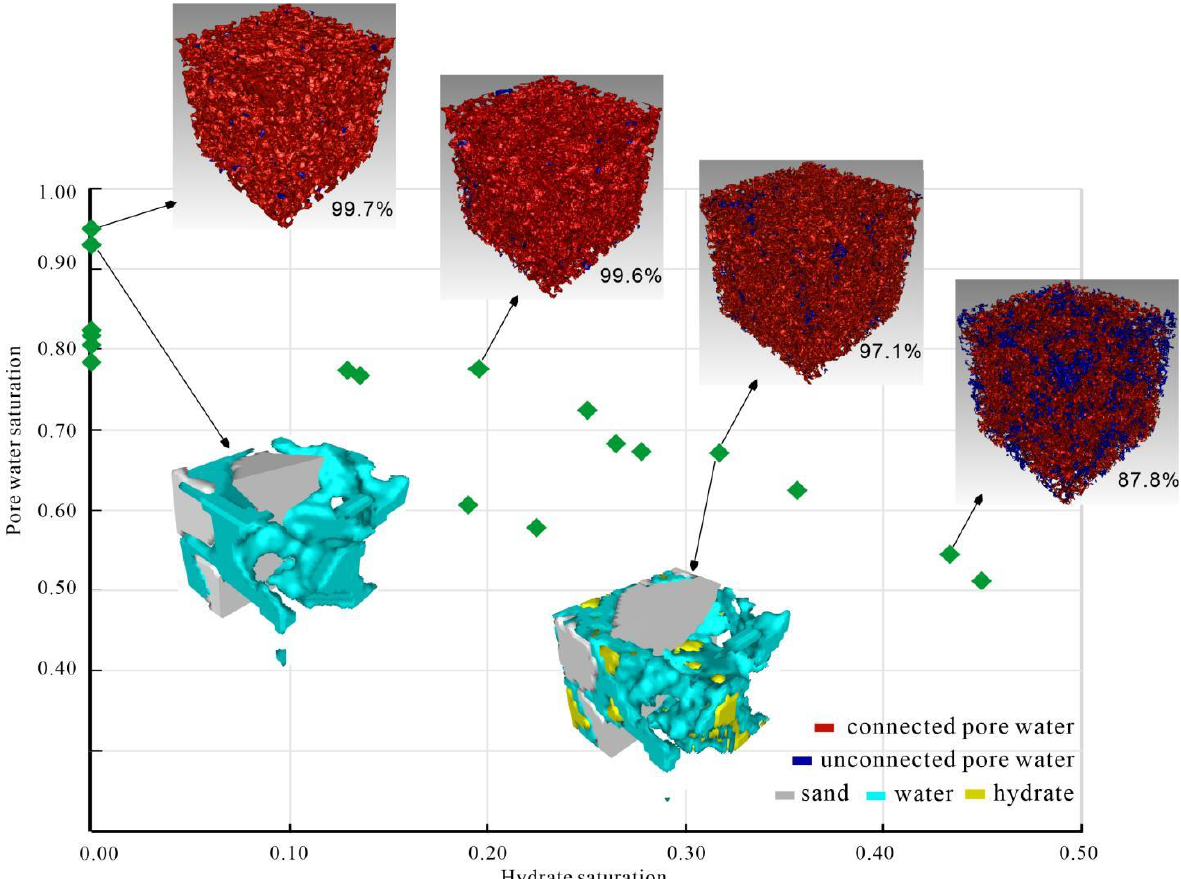
Figure 4. The content and distribution changes of pore water versus hydrate saturation. Six repre- sentative data of the initial state (hydrate saturation is zero) are presented. The three-dimensional X-CT images above show the pore water extracted from the three-dimensional X-CT images of the hydrate-bearing sediments. The three-dimensional X-CT images below show the distribution of pore water in a pore before ( left ) and after hydrate formation ( right ).